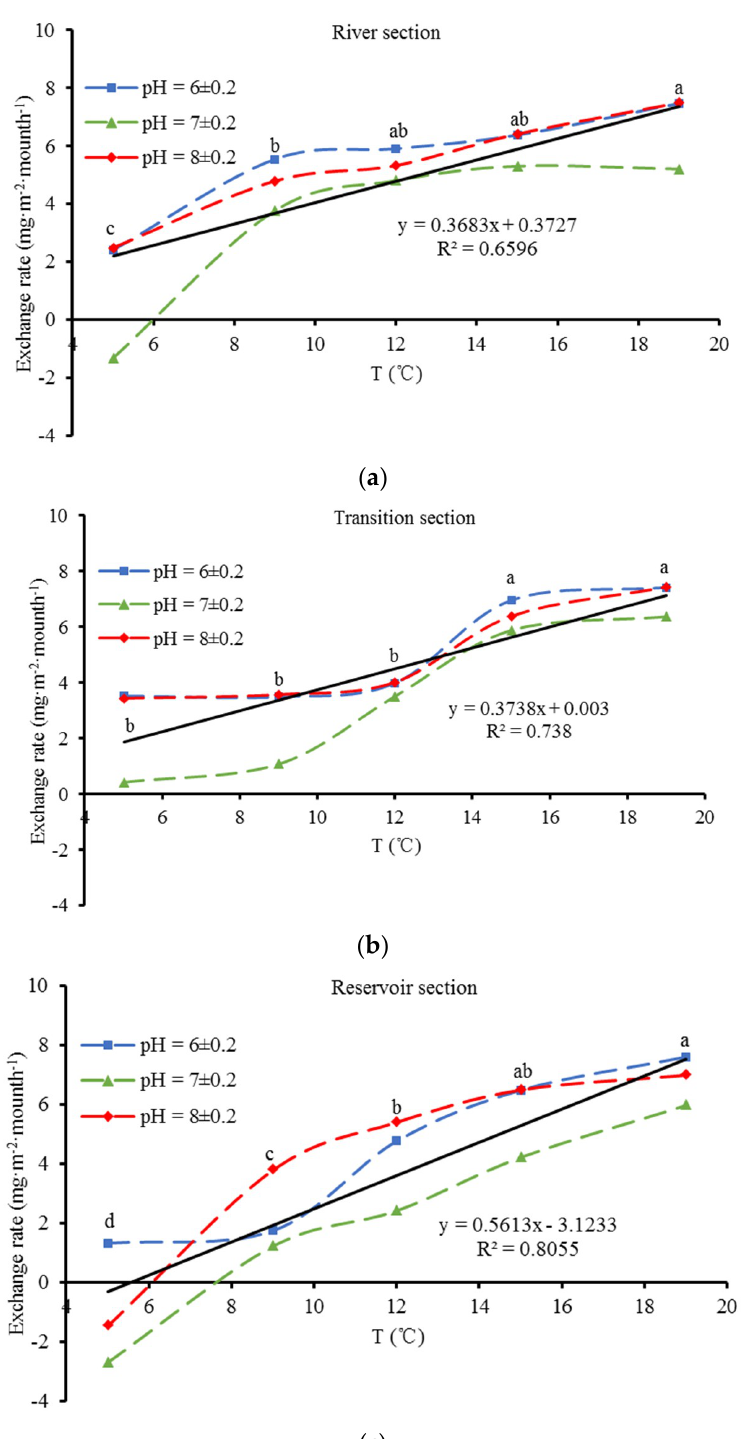
Figure 4. Exchange rate of phosphorus with varying temperature and pH values at different sections. Letters above the values indicate the results from a post hoc multiple comparison test (S-N-K test); values that do not share a common lowercase letter indicate a significant difference between temperatures ( p < 0.05).